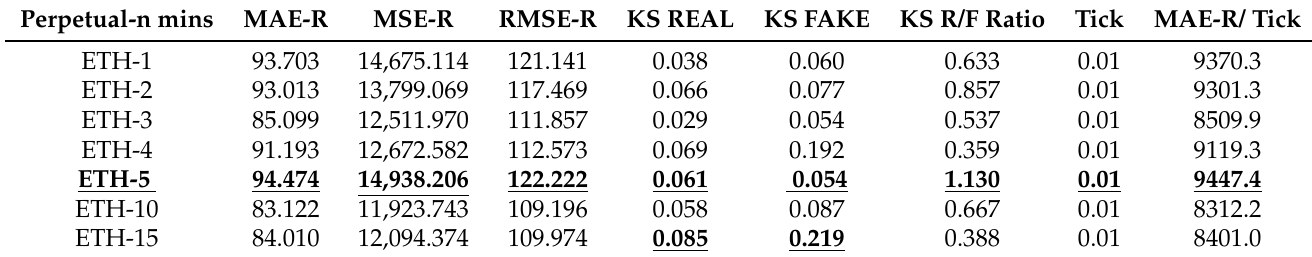
Table 17. We compared ETHUSDT perpetual prices at multiple intervals. The smallest KS REAL and KS FAKE are 0.029, and 0.054. The highest KS REAL and KS FAKE are 0.085 and 0.219 respectively. ETHUSDT perpetual 15 min intervals, KS R/F Ratio is 0.388 where KS REAL is 0.085, indicating the generated prices are indeed close to original price inputs. Only ETHUSDT 5 min intervals generated FAKE outperform the generated REAL, the R/F Ratio is 1.130.